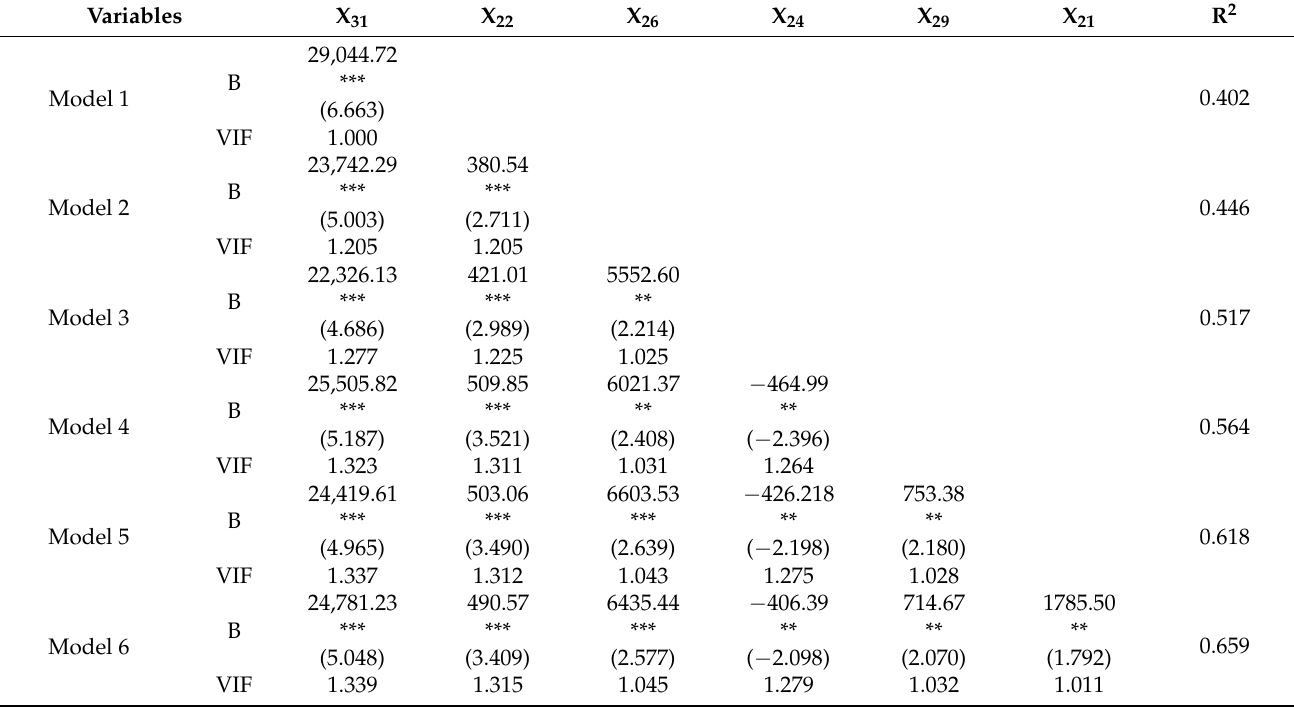
Table 5. Results of the price model of residential